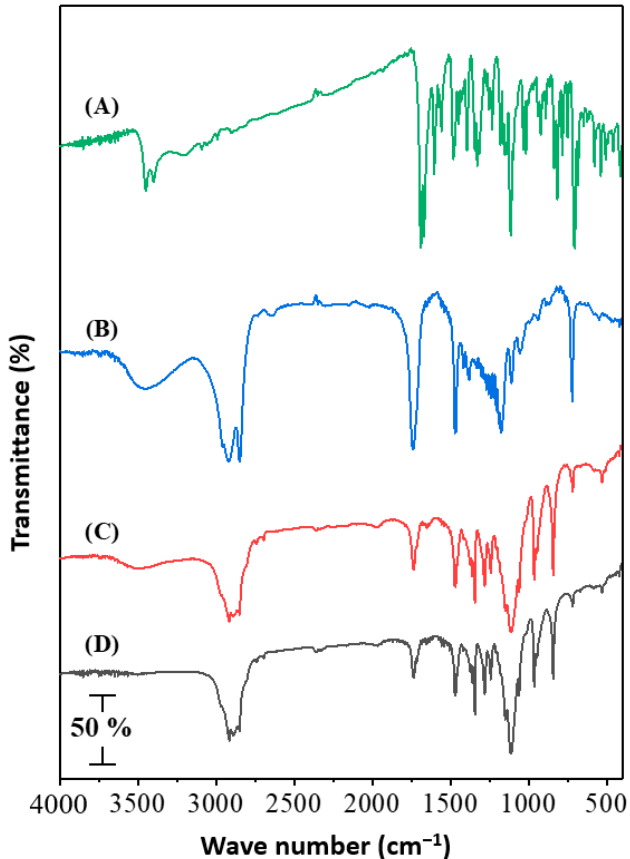
Figure 4. FTIR spectra of ( A ); Temazepam powder, ( B ) Compritol ® 888 ATO powder, ( C ) Plain NLC-1 freeze-dried powder, and ( D ) Temazepam NLC-1 freeze-dried powder.